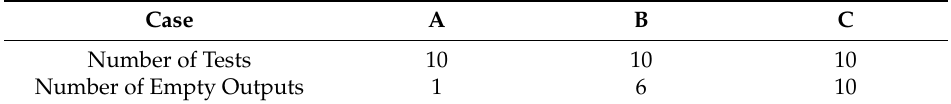
Figure 6. Test setup: the red point is the station; the gray bars denote desks and cupboards; and the different positions of people represent different cases. Table 2. Results of the test for different cases.